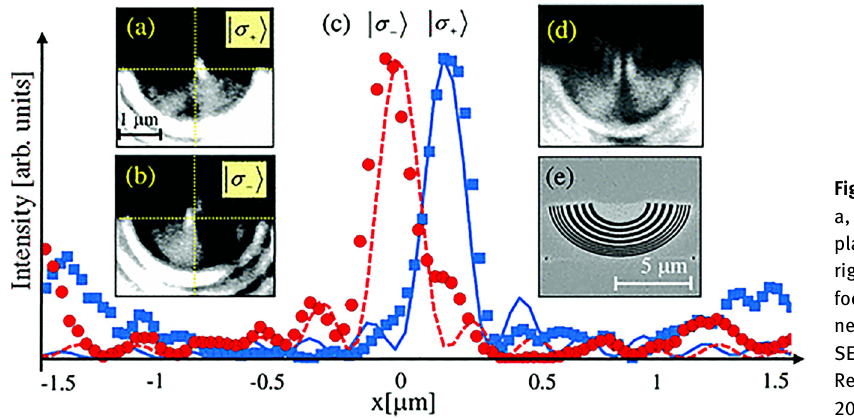
Figure 12: Plasmonic lens based on PSHE. a, b: near-field scanning images of the plasmonic lens by the irradiated of left/ right-handed circularly polarized beams. c: focus distribution of the plasmonic lens. d: near field image of the plasmonic lens. e: SEM of the plasmonic lens